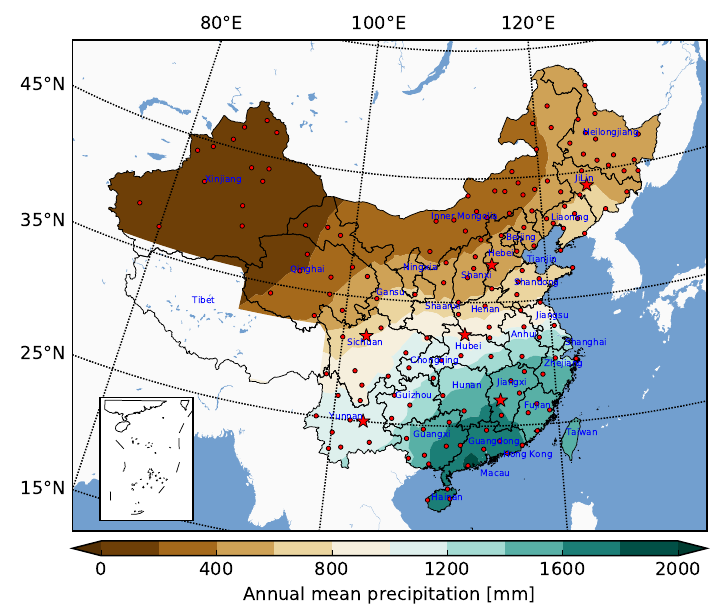
Figure 1. Locations of meteorological observation stations and contours of mean annual precipitation in China. Stars represent selected stations: Changchun (station No. 54161) in Jilin; Shijiazhuang (station No. 53698) in Hebei; Laohekou (station No. 57265) in Hubei; Maerkang (station No. 56172) in Sichuan; Kunming (station No. 56778) in Yunnan; and Jianxian (station No. 57799) in